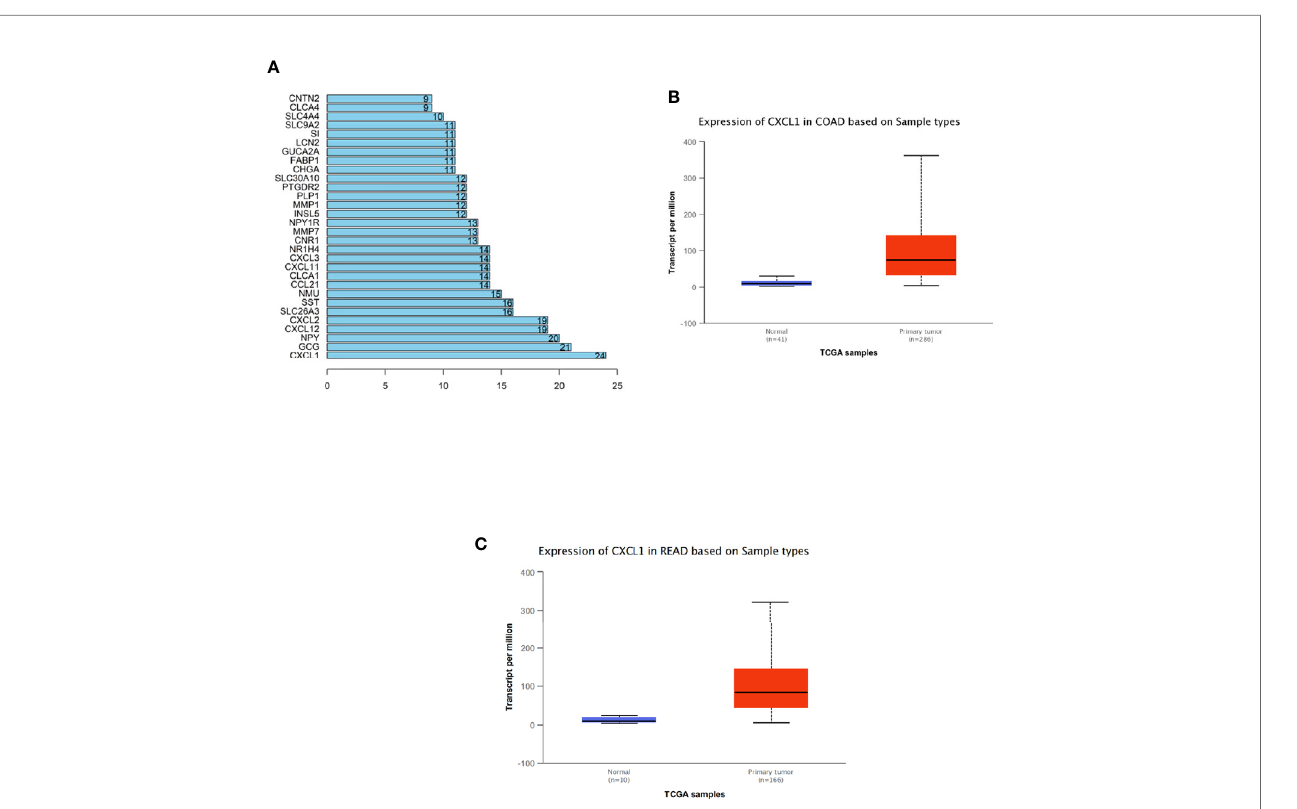
FIGURE 1 | Analysis of DEGs in CRC via bioinformatics methods. (A) Degrees of the top 30 DEGs among all the screened CRC-related differential genes from GEO. The abscissa refers to degree and the ordinate refers to the gene, (B, C) Expression levels of CXCL1 in TCGA-COAD (colon adenocarcinoma) and TCGA-READ (rectum adenocarcinoma) datasets (blue: normal; red: tumor). The abscissa refers to sample type and the ordinate refers to the transcript per